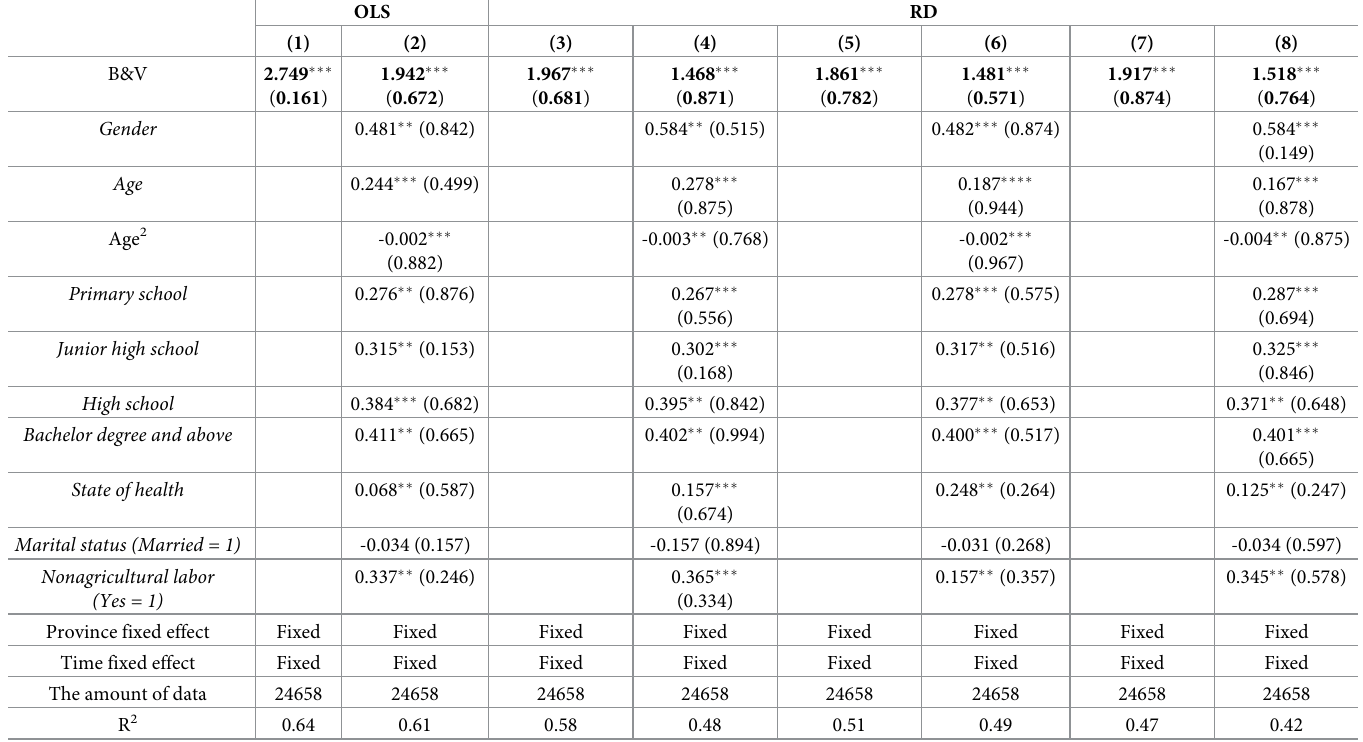
Table 2. Basic regression results of the effect of B&V on the income level of rural